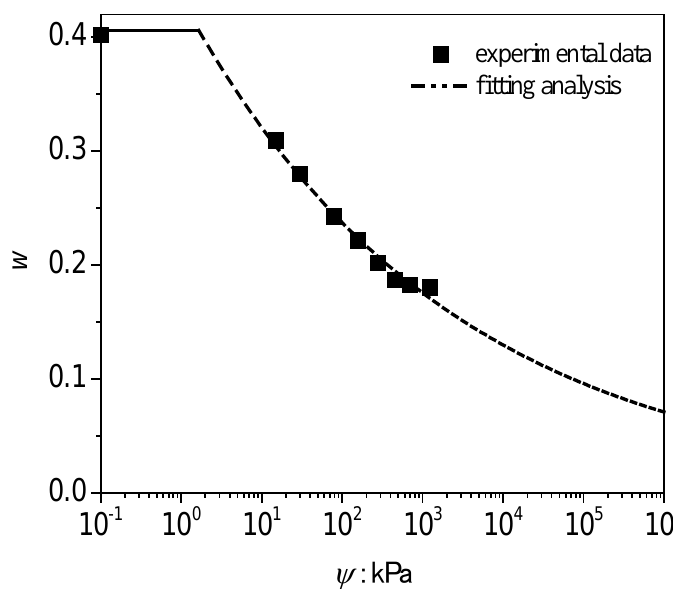
Figure 4. Determination of air-entry values at reference state through fitting Equation (12) to the experimental SWCCs for Wuhan Clay with e 0 = 1.115.